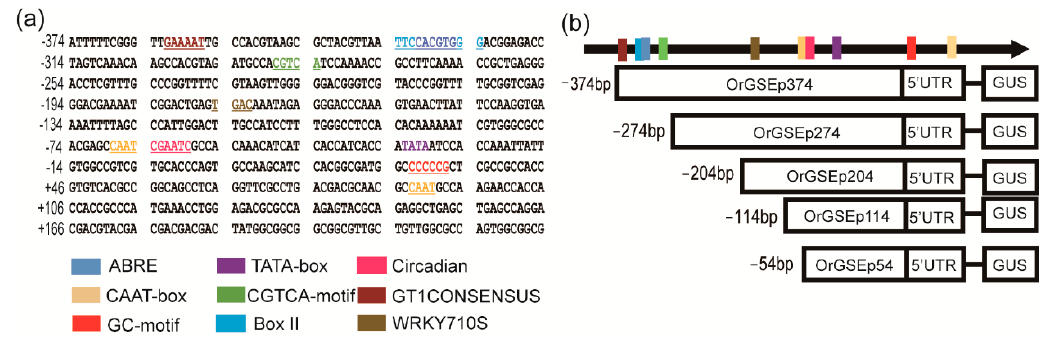
Figure 2. The location of putative cis-acting elements in OrGSEp-374 predicted by the PlantCARE database and schematic diagrams of promoter deletion constructs. ( a ) Putative cis-acting elements in OrGSEp-374, The 5 ′ -region of the OrGSE gene containing the 374 bp promoter sequence and 166 bp sequence downstream of the translational start site. The transcription initiation site is defined as +1. The TATA box, CAAT box and other key cis-acting elements are underlined with and indicated by different colors as shown in the legend. The position of each element is also indicated by schematic diagrams; ( b ) The schematic diagrams of the truncated OsGSE-374 constructs. The numbers to the left of these diagrams indicate the position of the 5 ′ -deletion.